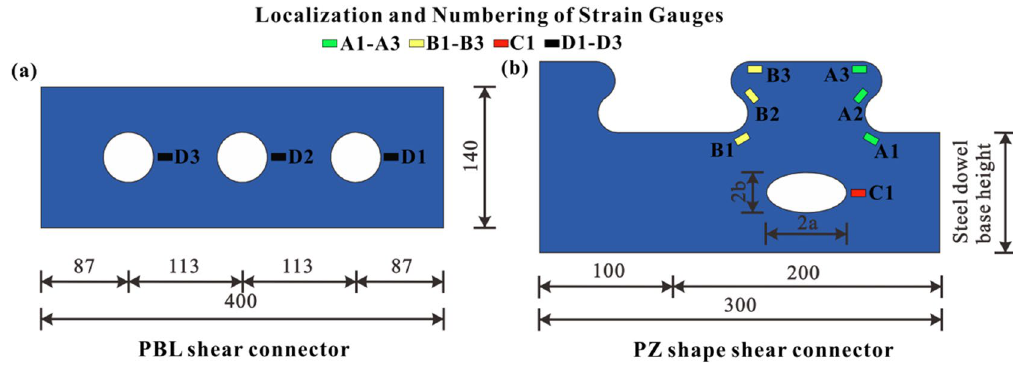
Figure 2. Geometry of PBL and PZ shear